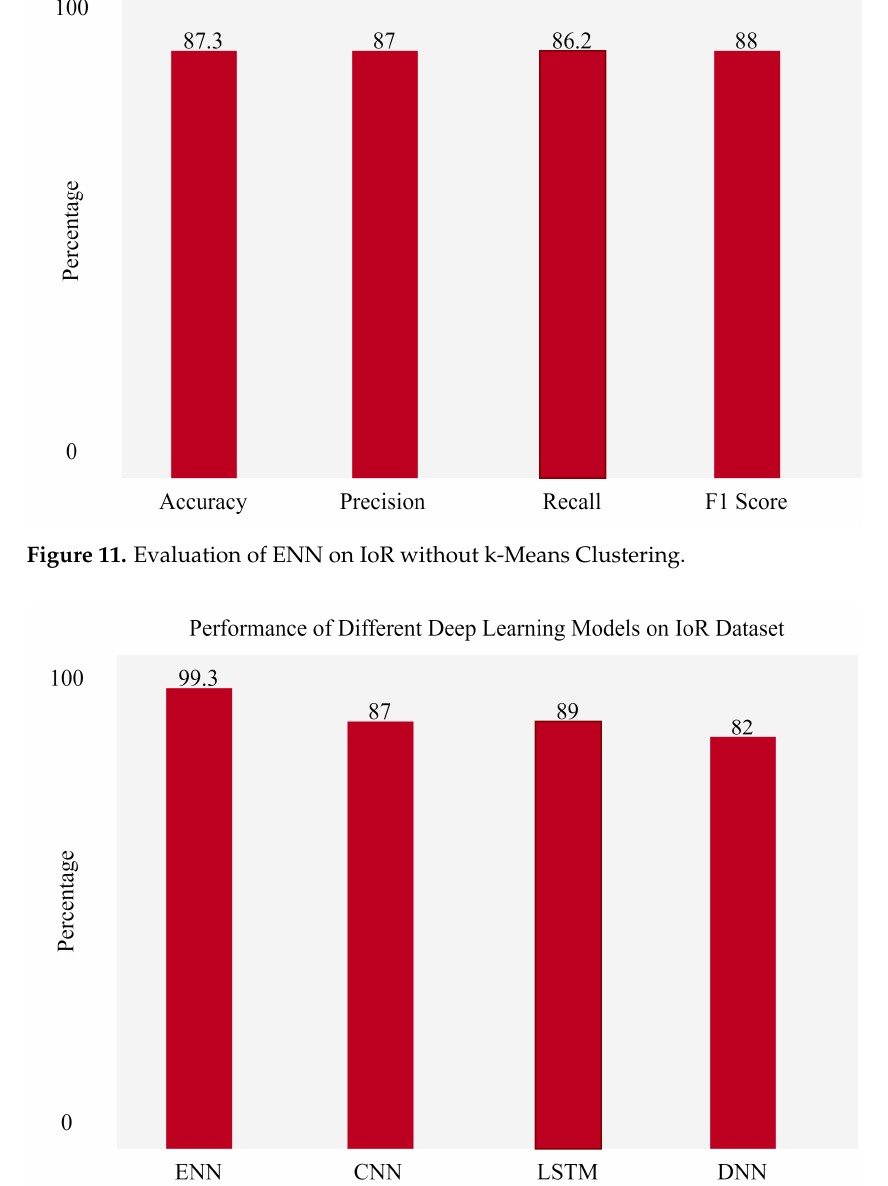
Table 4. Comparative Analysis of Previous and Current Studies.